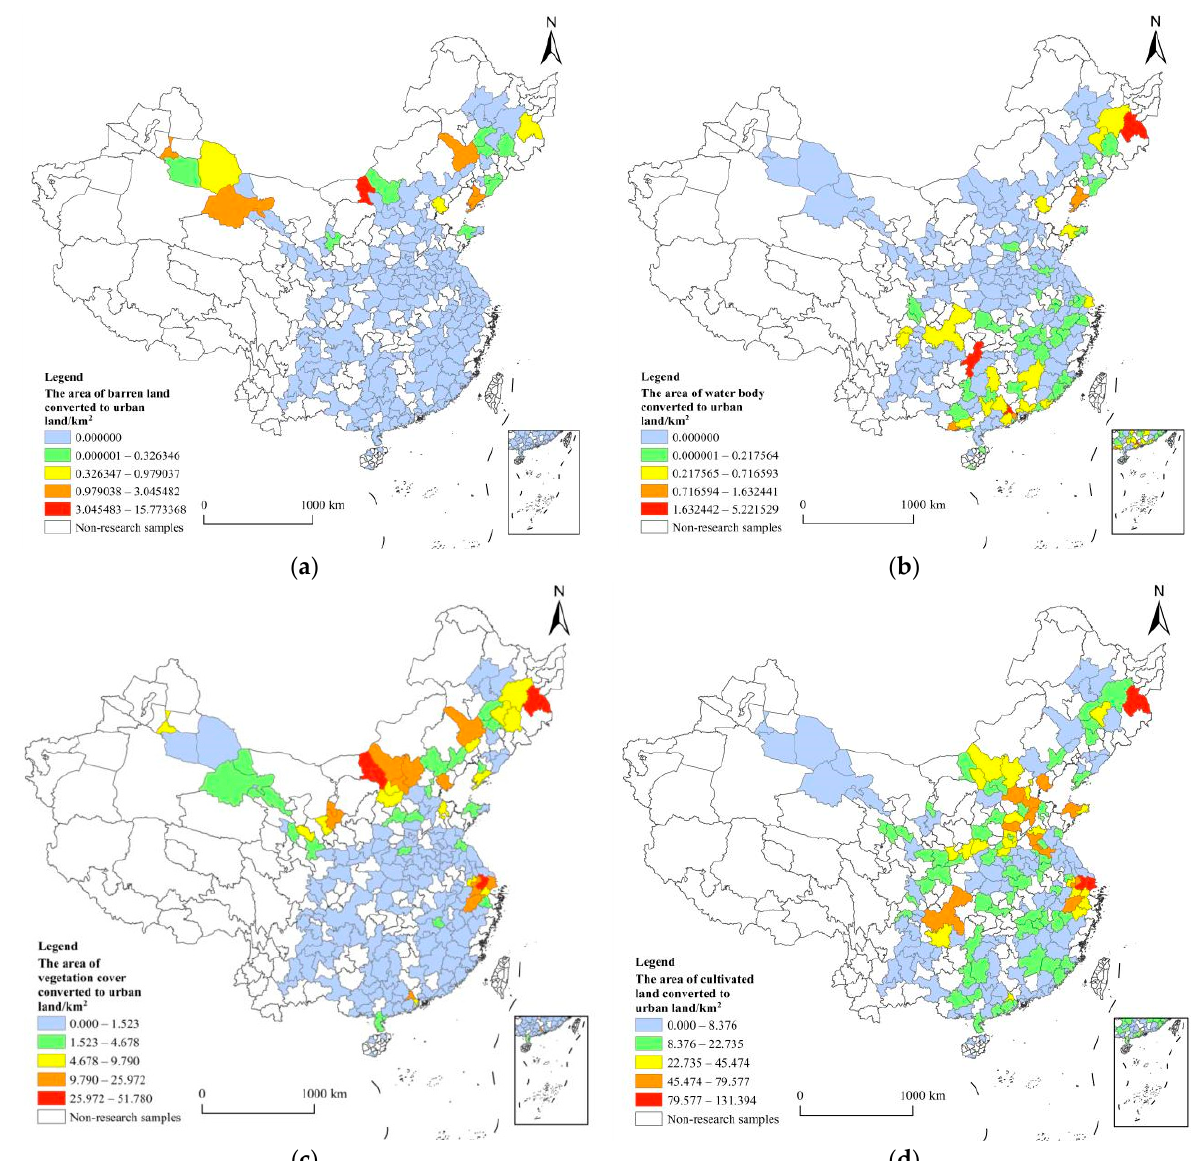
Figure 7. The area of non-urban land converted to urban land in the cities that first opened HSR during 2010 to 2019. ( a ) The area of barren land converted to urban land; ( b ) the area of water body converted to urban land; ( c ) the area of vegetation cover converted to urban land; ( d ) the area of cultivated land converted to urban land.